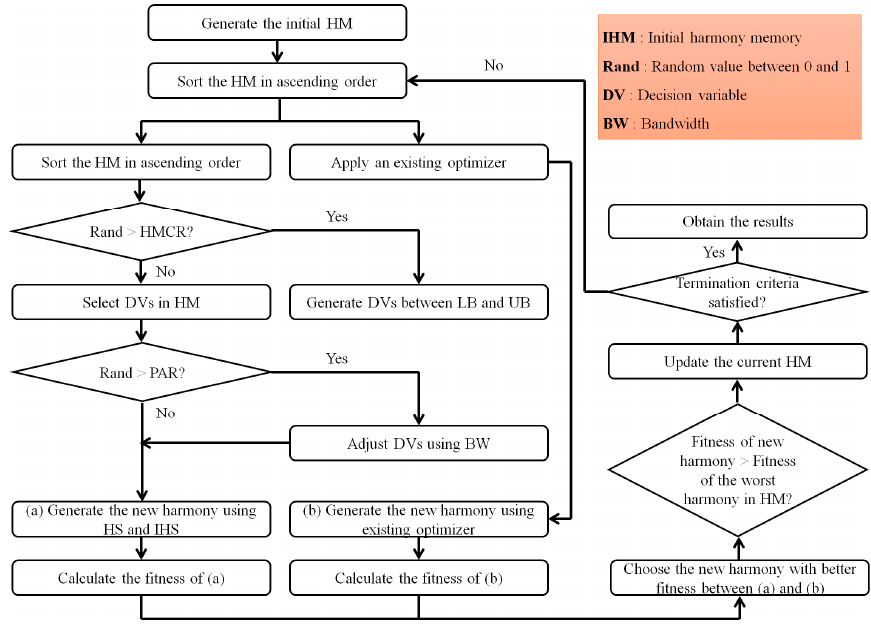
Figure 4. Calculation fl owchart for MLP using optimizers combined with HS and IHS.